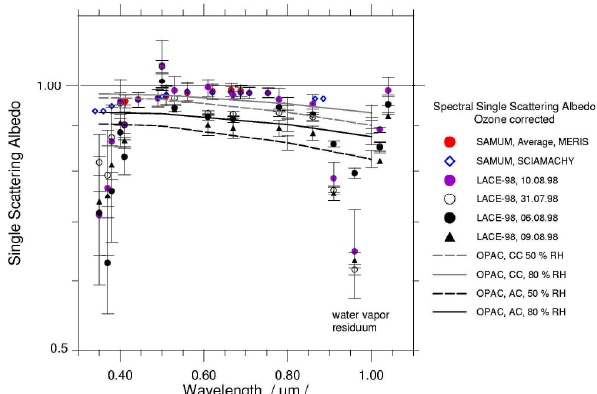
Fig. 9. Experimental spectra of single scattering albedo of LACE- 98 and SAMUM in comparison with the continental aerosol model of OPAC (AC – average continental, CC – clean